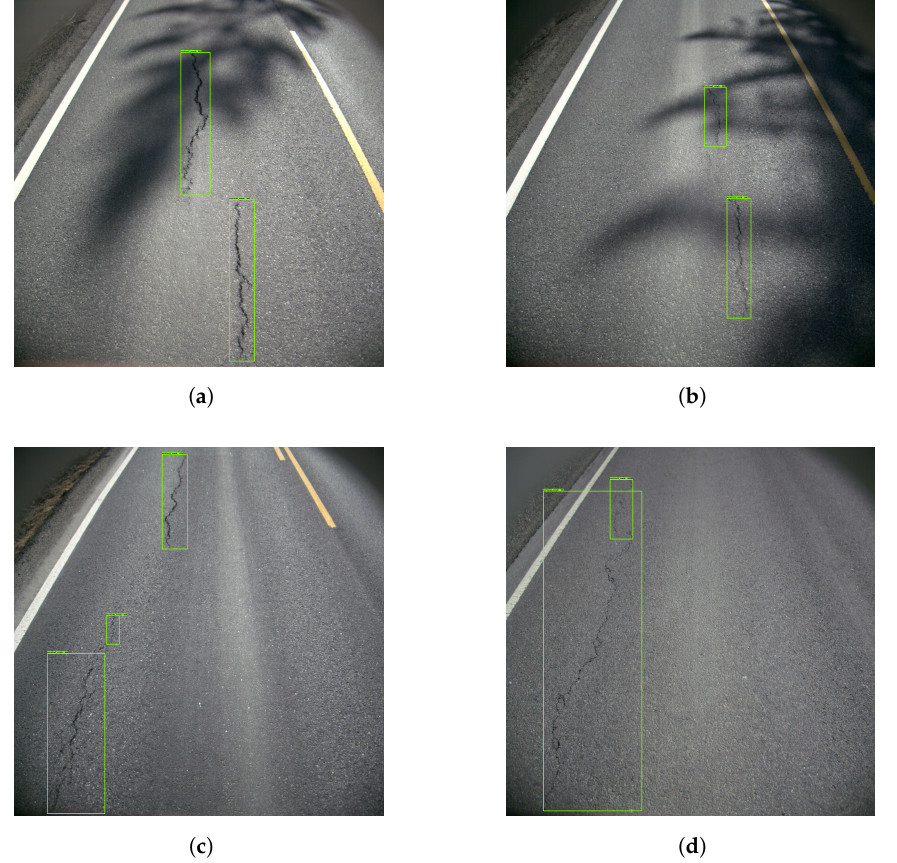
Figure 8. Examples of good vertical crack detection. The green boxes represents the vertical